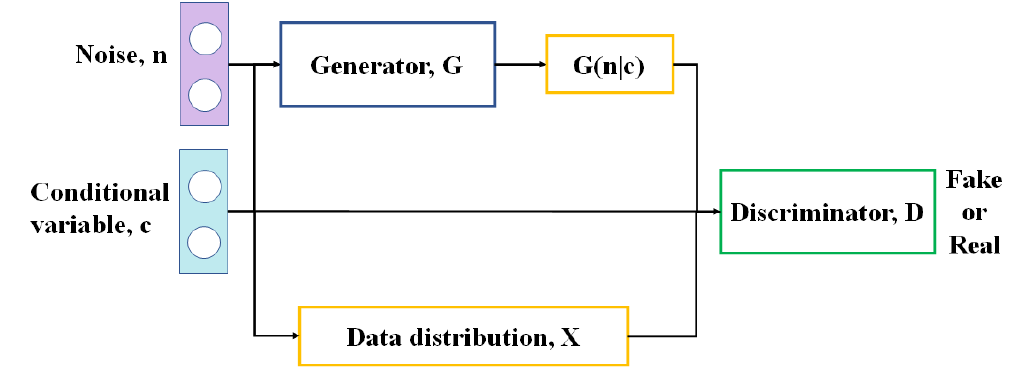
Figure 1. System workflow of conditional generative adversarial network (CGAN).